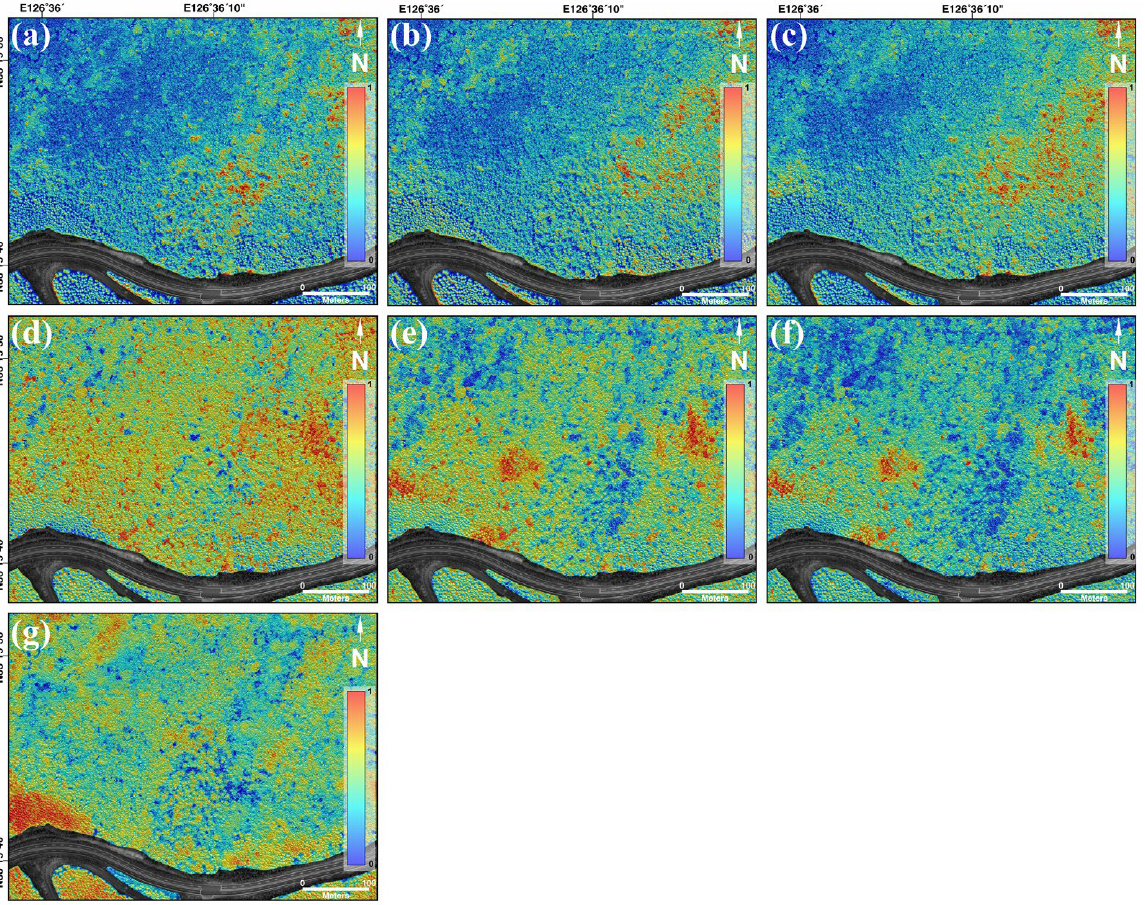
Figure 5. Normalized data acquired on 24 October: ( a ) red, ( b ) green, ( c ) blue, ( d ) GNDVI, ( e ) NDRE, ( f ) CI, and ( g ) canopy height maps.